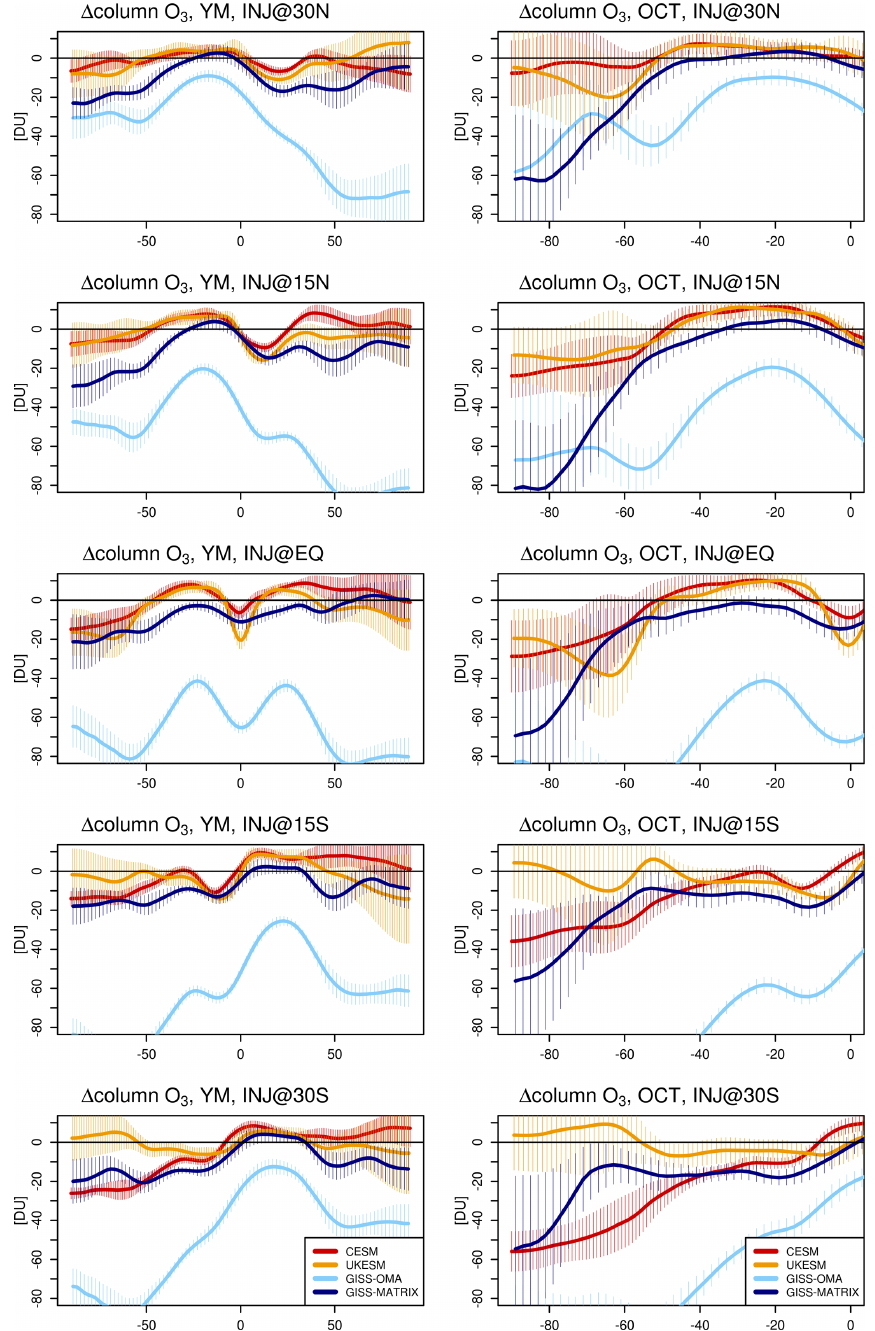
Figure 9. Yearly mean (YM; left) and October mean (OCT; right) changes in total column ozone [DU] averaged over the last 8 years of the simulations compared to the same period in the SSP2–4.5 run for CESM (red), UKESM (orange), GISS-MATRIX (dark blue), and GISS-OMA (light blue). Error bars indicate ± 2 standard errors of the difference in